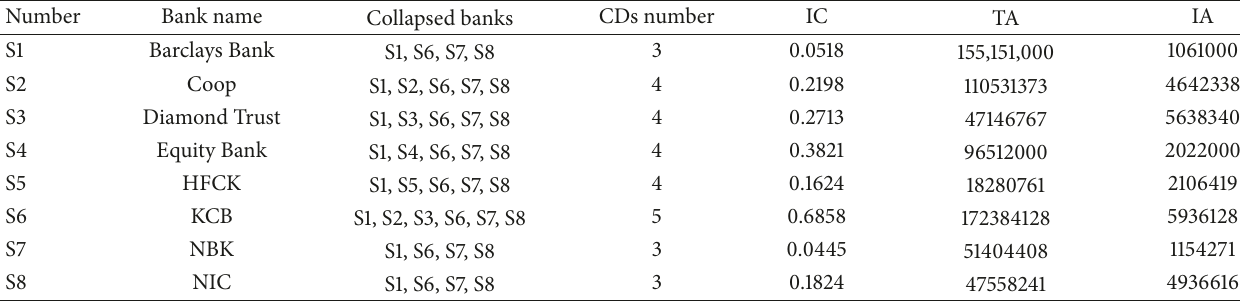
Table 2: Results of stress test in 2009; CDs number: number of contagious defaults; IC: interconnectedness: the total strength, namely, sum of in-strength and out-strength; TA: total assets; IA: interbank assets (loans and advances to banks). Total assets are measured at market value, whereas interbank assets are measured at book value. We use the letters s1, s2, s3, s4, s5, s6, s7, and s8 to stand for Barclays Bank, Coop, Diamond Trust, Equity Bank, HFCK, KCB, NBK, and NIC, respectively. The unit of currency is Shs.